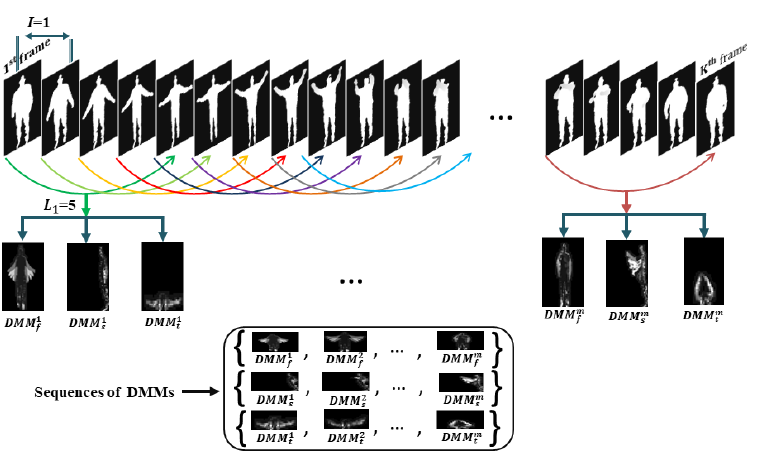
Figure 2. Construction of DMMs sequences according to sub-sequences of 5